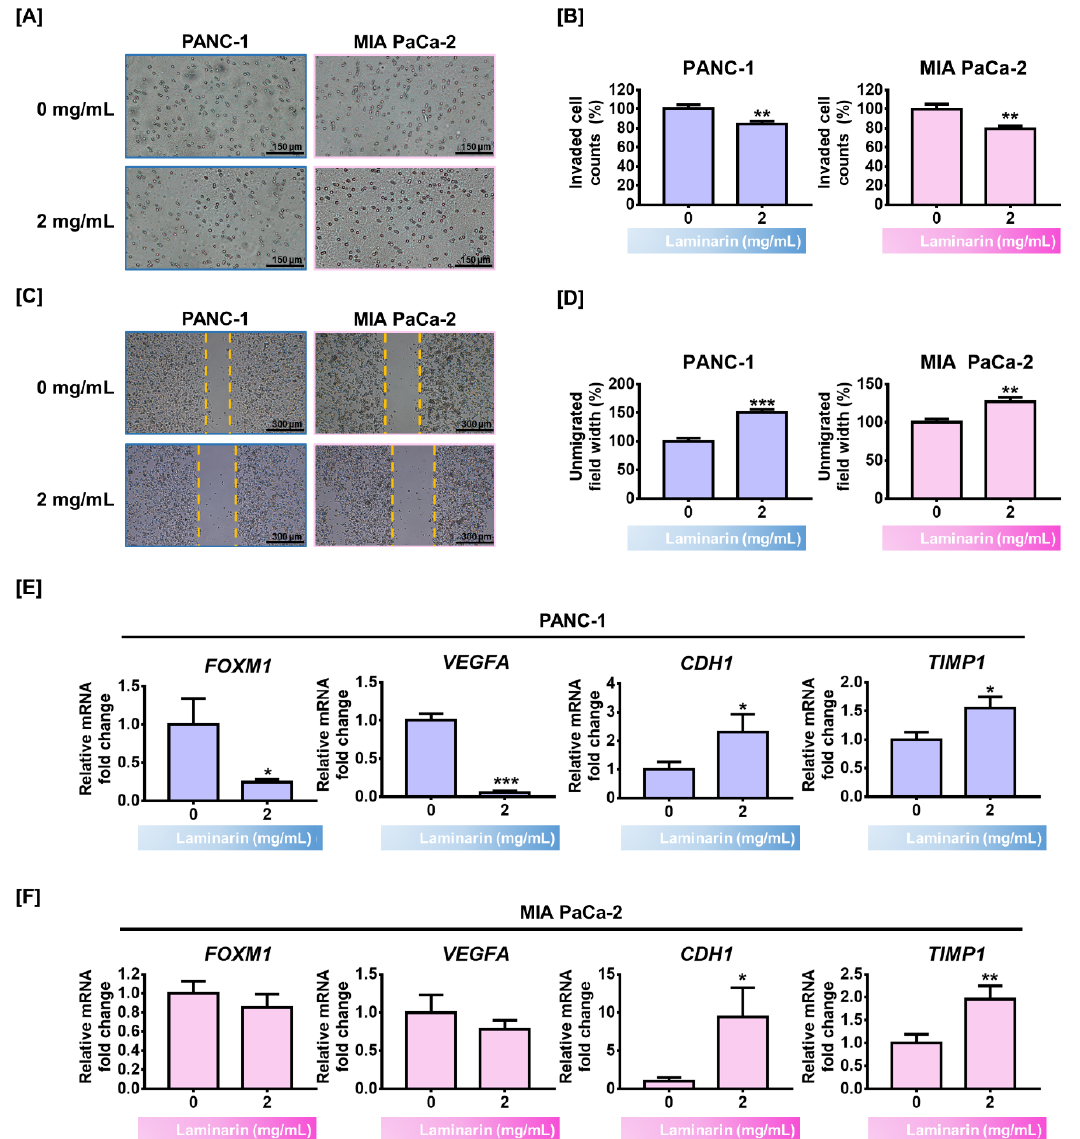
Figure 4. Inhibitory effects of laminarin on cell migration and invasion in PC cells. ( A , B ) Transwell invasion assays of PC cell invasion. Graph shows relative numbers of cells that passed through membrane. Scale bar: 150 μ m. ( C , D ) Cell migration in Ibidi 35 mm culture dishes. Graph shows relative gap between divided cell populations. Scale bar: 300 μ m. ( E , F ) Invasive FOXM1 , VEGFA , CDH1 , and TIMP1 gene expression in PC cells determined by qRT ‐ PCR. (* p < 0.05, ** p < 0.01, *** p < 0.001; laminin vs. control). All experiments were conducted in triplicate.